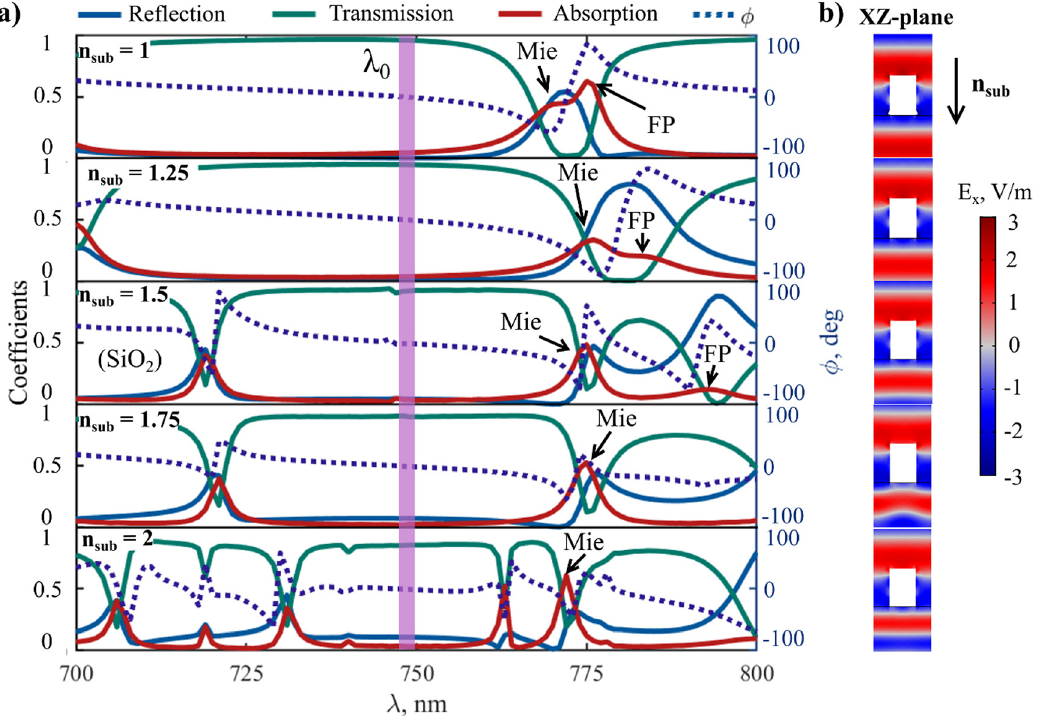
Figure 5: (a) Optical response of an HA metasurface with inter-particle separation s = 300 nm, and geometrical parameters as in Figure 1, deposited on hypothetical substrates with increasing refractive index. The arrows indicate the evolution of the Mie-like and Fabry – Perot (FP) modes responsible for the HA. (b) x -component of the electric fi eld at λ 0 for the cases considered in